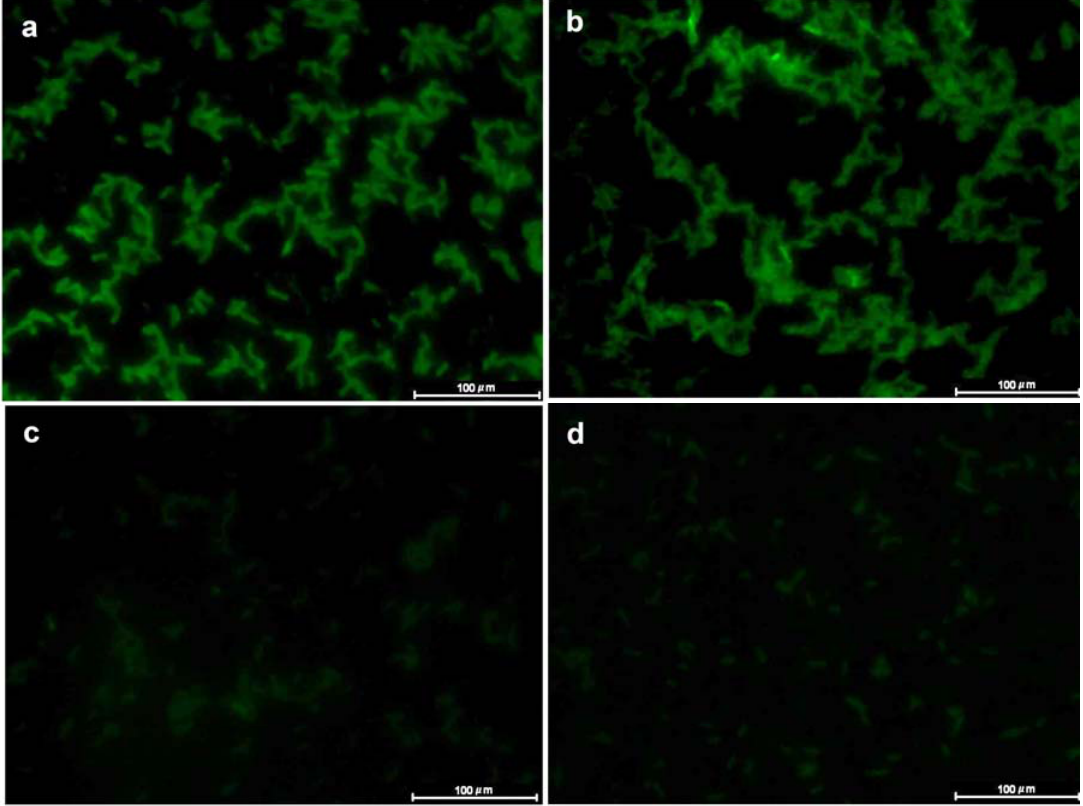
Figure 1. Lectin-fluorescence microscopy of interaction between FITC-lectins and Rhizobium tropici CIAT 899. ( a ) FITC-ConA; ( b ) FITC-ConBr; ( c ) FITC-ConA plus D -mannose; and ( d ) FITC-ConBr plus D -mannose.